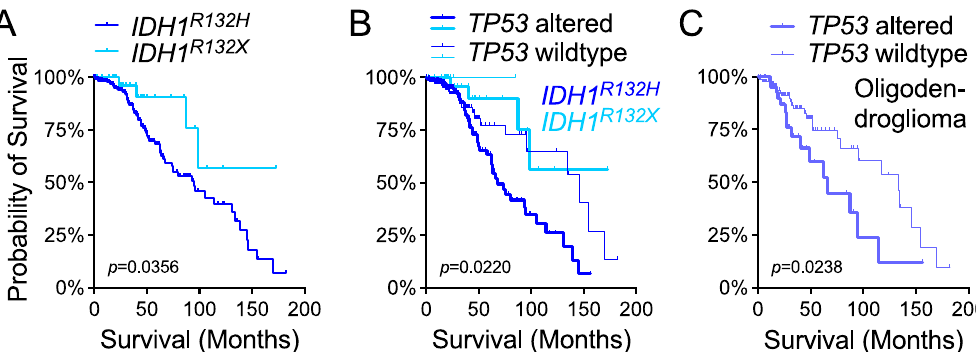
Figure 5. TP53 status determines patient survival outcomes in molecular and histological subgroups of lower-grade glioma in TCGA_PanCancer. Differences in overall survival were analyzed between IDH1 R132H and IDH1 R132X subgroups ( A ) and among those of TP53 wildtype (thin line) and TP53 altered (thick line) ( B ). Overall survival was also analyzed in the oligodendroglioma subgroup with respect to TP53 status ( C ). Two-tailed p -values are specified. Table 6. Multivariate Cox proportional hazards analysis of TP53 status in the IDH1 hotspot mutation subgroup of TCGA-LGG dataset.